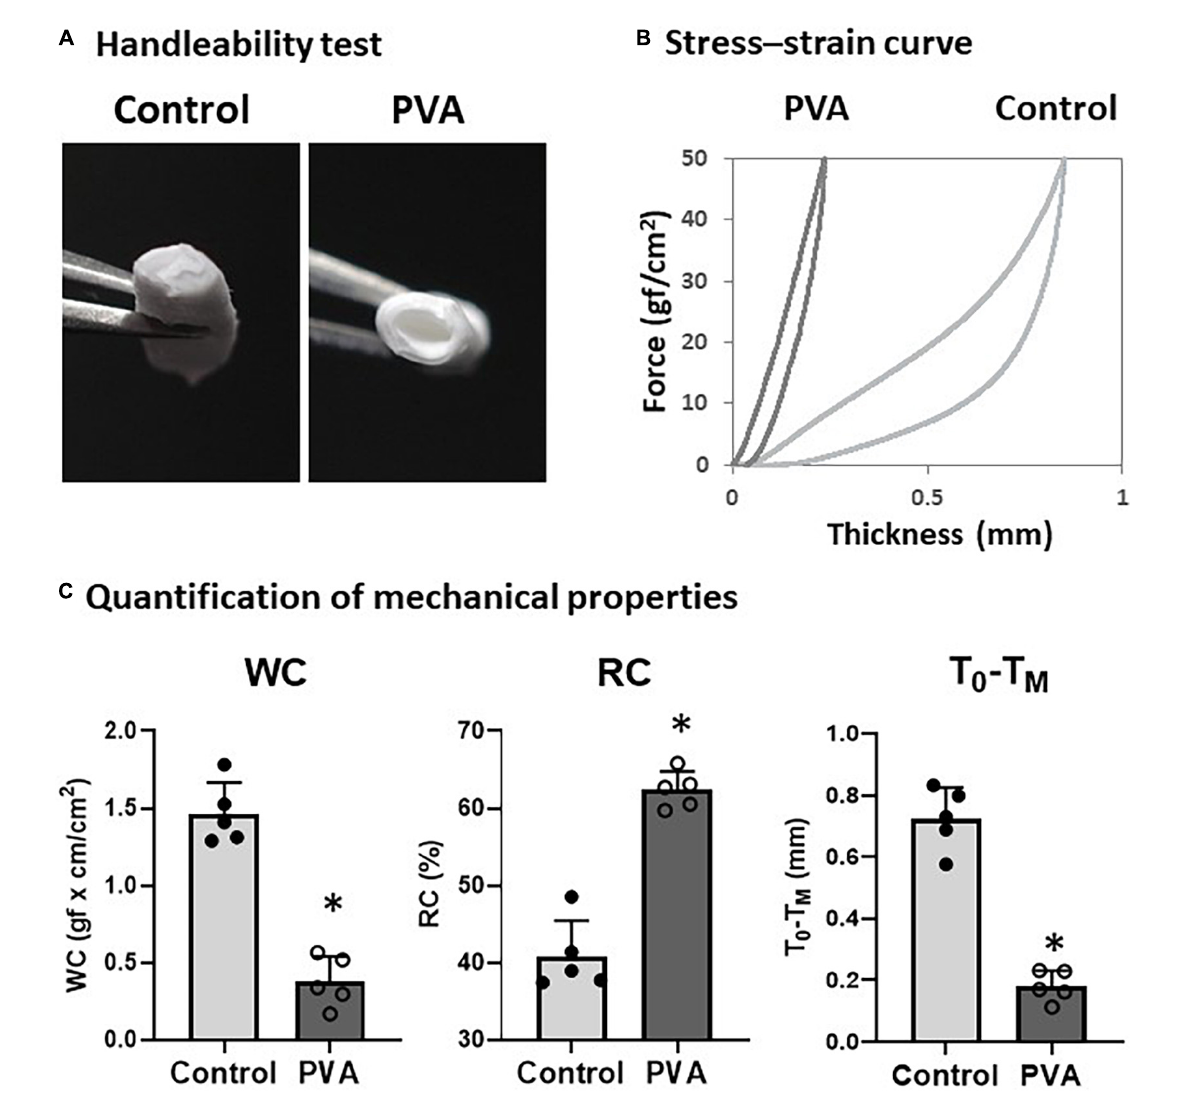
FIGURE2 Evaluation of mechanical properties of PVA–PCL graft. (A) Handleability test. Grafts were pinched with forceps 5 times and the resulting change in structure was captured. (B) Stress–strain curve measured using KES. Grafts were compressed with a maximum force of 50 gf/cm 2 and the distance between compression and recovery was measured using a compression tester. Independent measurements were repeated 5 times and the figure shows the representative data. (C) Quantification of mechanical properties measured by KES. WC represents susceptibility against compression. Higher value of RC and smaller T 0 –T M represents resiliency and recoverability. The graphs are expressed as the mean ± SD and the data points represent the individual values in each group. ∗ Denotes p <